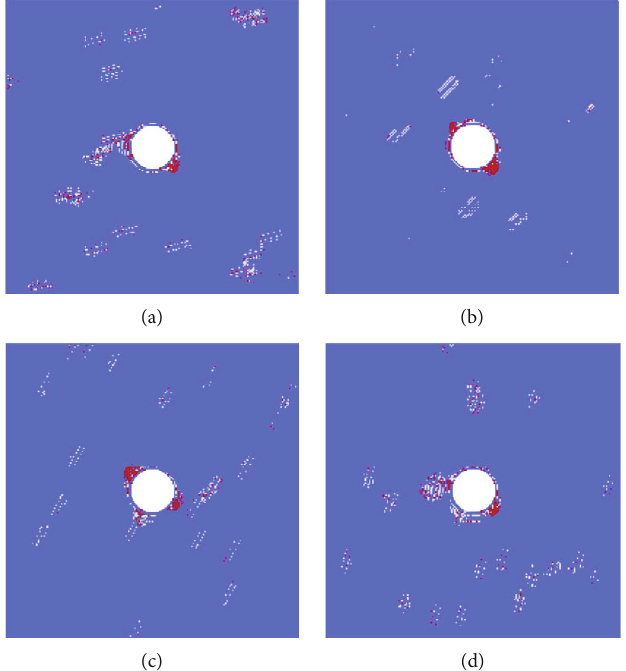
Figure 7: Excavation damage range under di ff erent fi ssure dip angles. (a) α = 15 ° . (b) α = 45 ° . (c) α = 60 ° . (d) α = 75 °